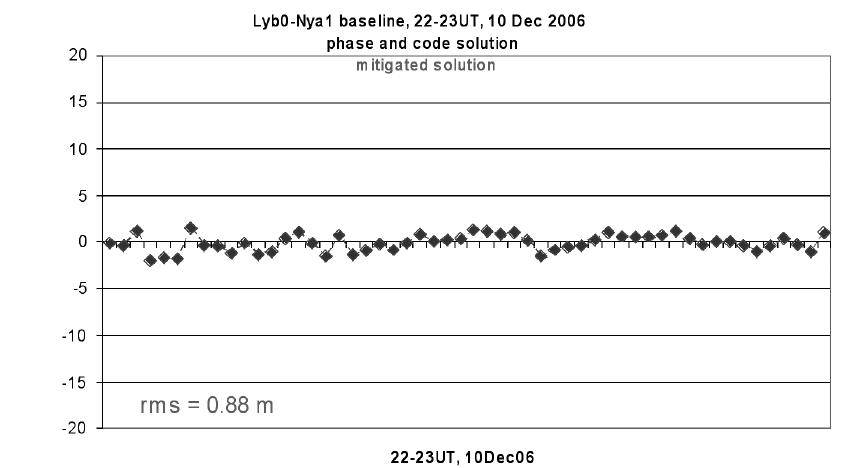
Fig. 22. Height errors from pseudoranges and carrier phase solution with